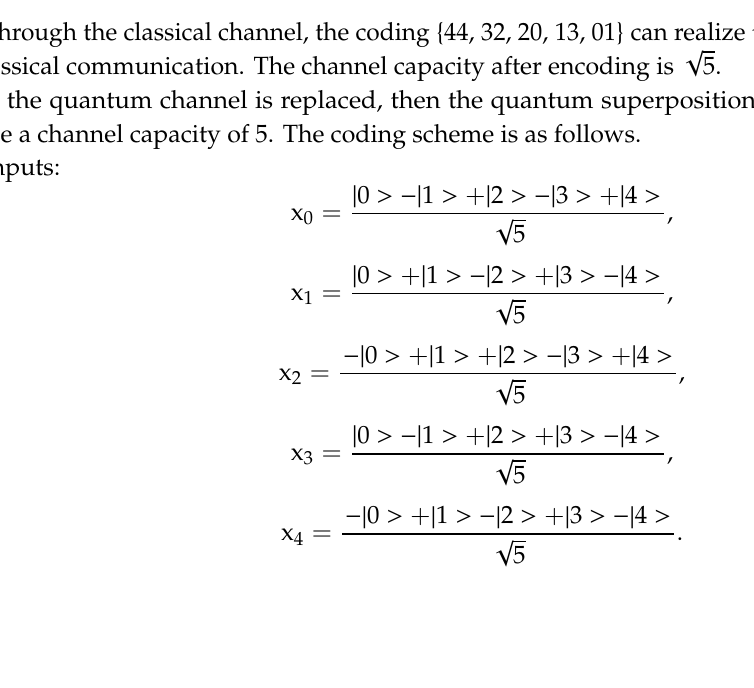
Figure 5. ( a ) Classical pentagonal channel; ( b ) quantum pentagonal coefficient channel.